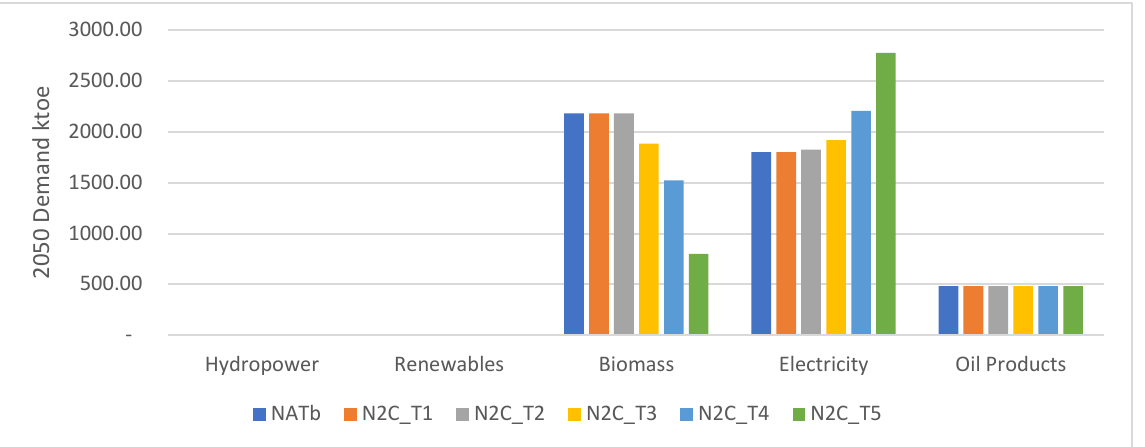
Figure 5. Energy demand by 2050 for scenarios based on NATb.